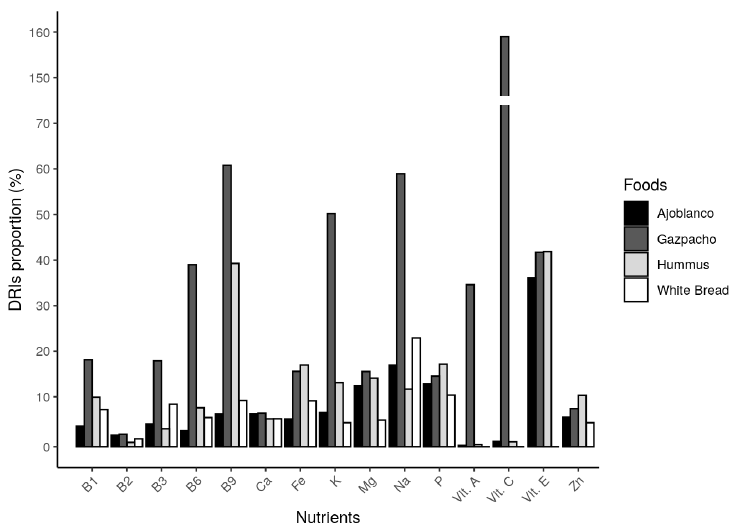
Figure 6. Percentage of vitamins and minerals provided by the ingested amount of each tested food, represented as a percentage of the dietary reference intakes (DRI) for each micronutrient. The contribution of carotenoids regarding a general intake recommendation [28] was also calculated. The results show that gazpacho is the food that contributes the largest amount of the compound followed by humus and ajoblanco, with all providing more than the recommend